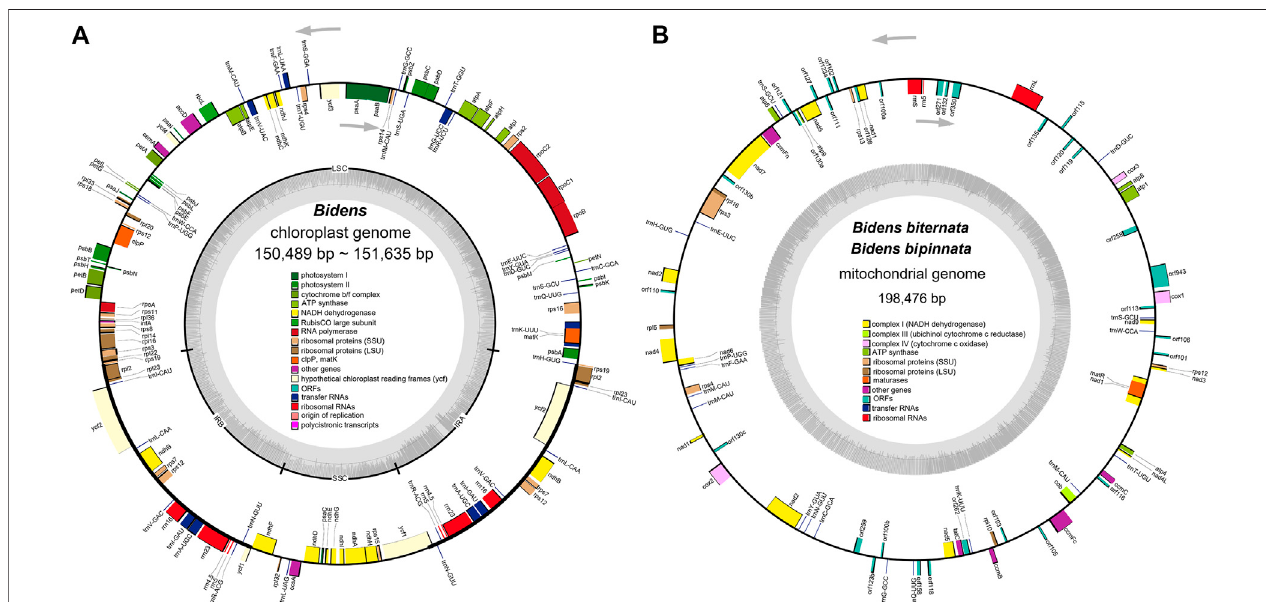
FIGURE 1 | Chloroplast (A) and mitochondrial (B) genome maps of Bidens species. The transcription directions of the inner and outer genes are listed clockwise and anticlockwise, respectively, and are represented by arrows. The dark grey colour in the inner circle corresponds to the GC content, whereas the light grey colour corresponds to the AT content.